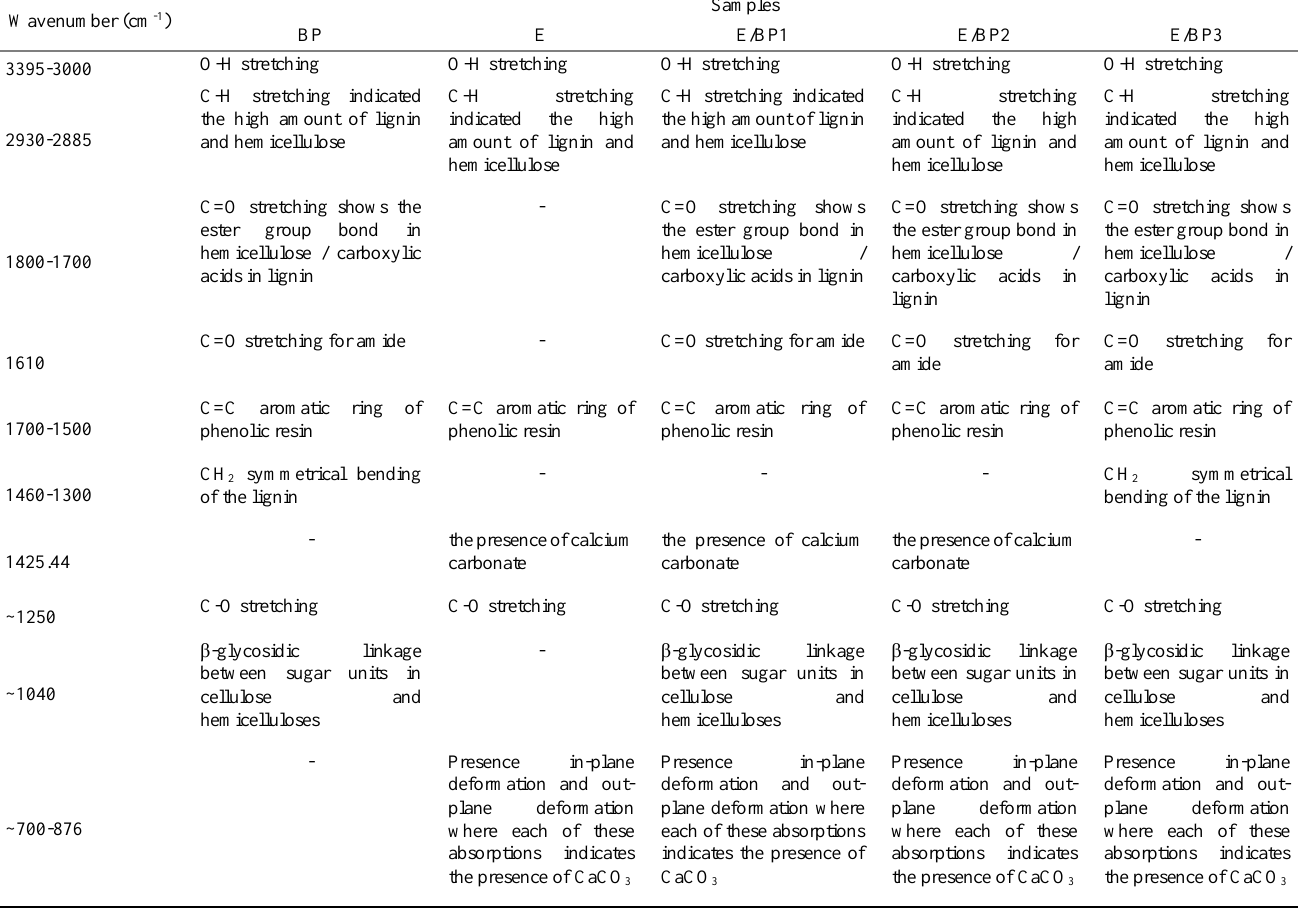
Table 3. The wavelength of peak used for FTIR analysis and its corresponding functional